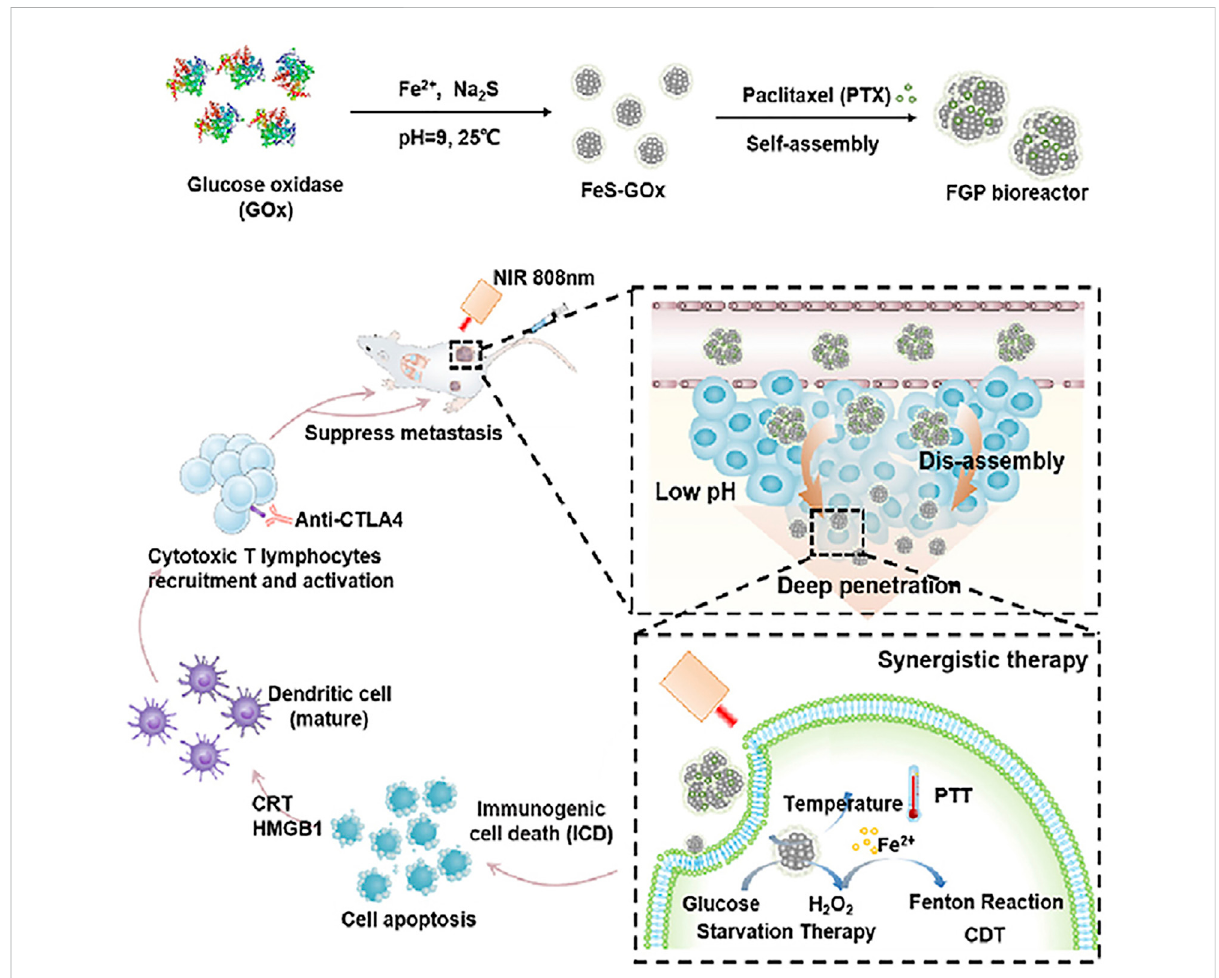
FIGURE 3 Schematic illustration of the synthetic process of FGP and the mechanism of antineoplastic therapy by applying FGP bioreactor. Reproduced with permission from Ref. (Ren et al., 2021). Copyright 2021 Elsevier.